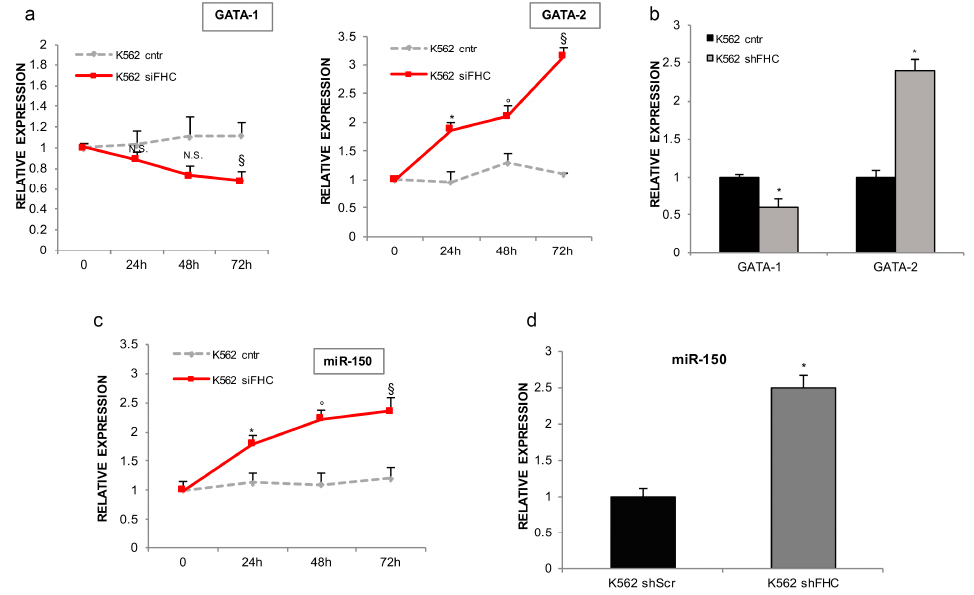
Figure 4. FHC silencing reduces GATA-1 and induces miR-150 up-regulation. ( a ) qRT-PCR analysis of GATA-1 and GATA-2 genes in transiently FHC-silenced K562 siFHC cells at 0 h, 24 h, 48 h, and 72 h, compared to control K562 cntr cells. All data represent mean ± SD ( n = 3). * p < 0.05 compared with K562 cntr at 24 h; ° p < 0.05 compared with K562 cntr at 48 h; § p < 0.05 as compared with K562 cntr at 72 h. N.S. not significant; ( b ) qRT-PCR analysis of GATA-1 and GATA-2 genes in stably FHC-silenced K562 shFHC cells compared to control K562 shScr cells. All data represent mean ± SD ( n = 3). * p < 0.05 compared with K562 shScr cells; ( c ) TaqMan analysis of miR-150 in transiently FHC-silenced K562 siFHC cells at 0 h, 24 h, 48 h, and 72 h, compared to control K562 cntr cells. All data represent mean ± SD ( n = 3). * p < 0.05 compared with K562 cntr at 24 h; ° p < 0.05 compared with K562 cntr at 48 h; § p < 0.05 compared with K562 cntr at 72 h; ( d ) TaqMan analysis of miR-150 in stably FHC-silenced K562 shFHC cells compared to control K562 shScr cells. All data represent mean ± SD ( n = 3). * p < 0.05 compared with K562 shScr cells.